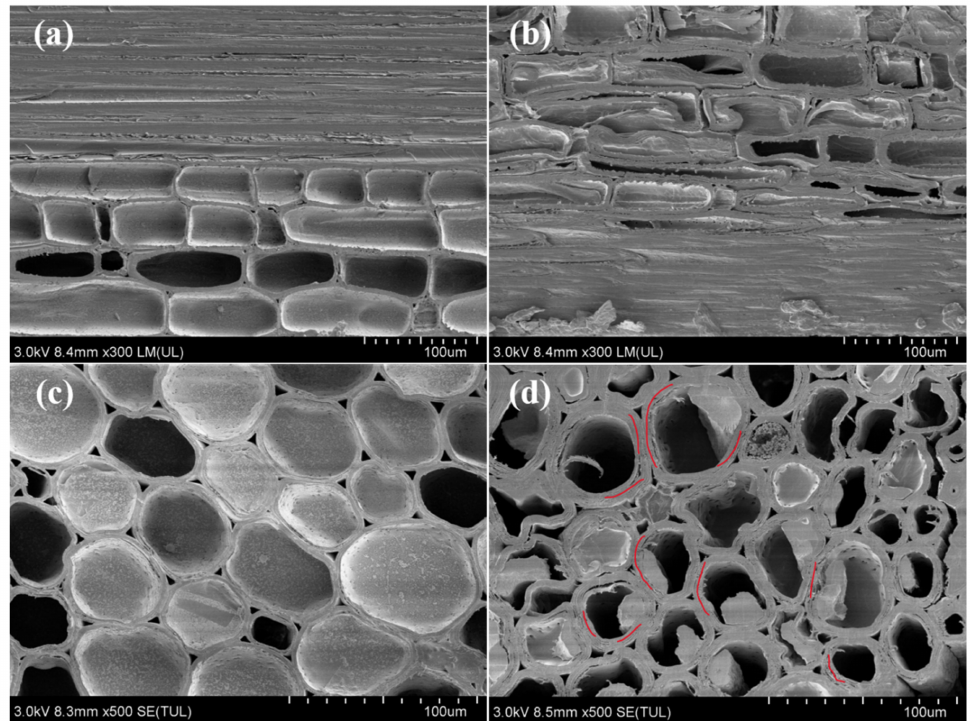
Figure 1. Scanning electron microscopy (SEM) images of ( a , c ) natural and ( b , d ) delignified bamboo. ( a , b ) Radial sections of natural bamboo (NB) and delignified bamboo (DB). ( c , d ) Cross sections of NB and DB.